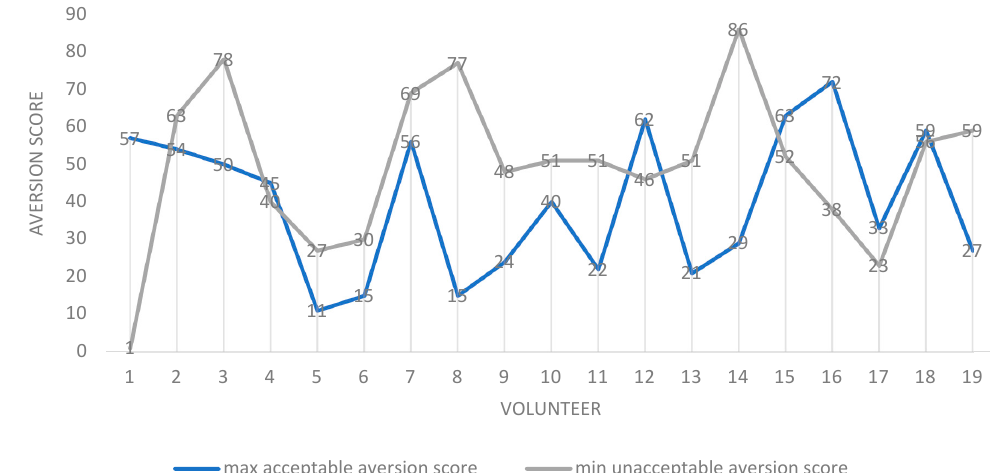
Figure 4. Scatter plot of maximum “acceptable-as-a-medicine” and minimum “unacceptable-as-a- medicine” aversion scores for all volunteers (participants). For each participant, the values are the mean for all 20 formulations assessed. Notes: 1. N = 19 as one volunteer was discounted as all samples were rated as acceptable as a medicine. 2. Volunteer 1 appears to be an outlier, as a sample rated as having an aversion value of 1 was described as being unacceptable as a medicine. This sample was also recorded as being “not gritty”. 3. In seven volunteers, contrary to expectation, the maximum “acceptable-as-a-medicine” taste scores were greater than the minimum “unacceptable-as-a-medicine” aversion scores: 1, 4, 12, 15, 16, 17 and